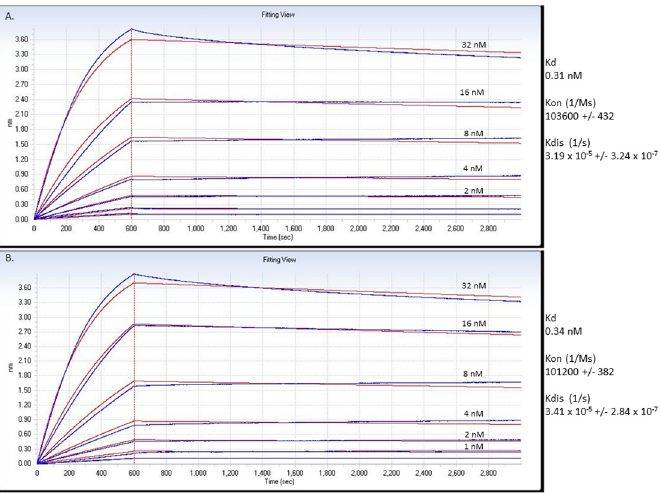
Fig 2. Definition of the relative affinity of the NCD1.2 MAB towards the epitope peptide. (A and B). NCD1.2 was titrated into reactions containing canine CD20 peptide on the solid phase in the absence or presence of DTT to evaluate potential oxidation effects on epitope binding. An Octet RED biolayer interferometry system that measures binding to the sensor tip as a wavelength shift (in nm) in real time. The assay data were processed using Data Analysis (version 6.3 — Forte Bio) to obtain kinetic values as in the materials and methods and tabulated as K d , K on and K diss . doi:10.1371/journal.pone.0148366.g002 since NCD1.2: (i) binds to canine and human CD20 peptide (unlike Rituximab); (ii) NCD1.2 binds to a small peptide sequence derived from human CD20 (unlike Rituximab); and (iii) Rituximab binds to human CD20+ cancer cells under conditions in which NCD1.2 is unable to compete.